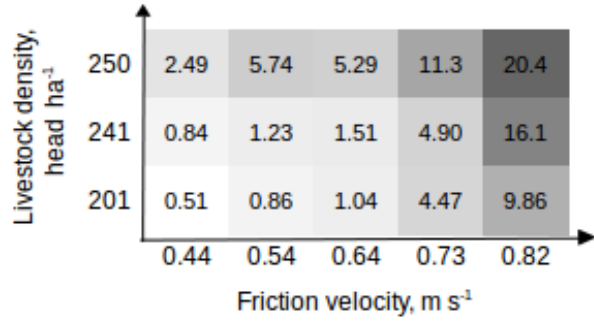
Figure 7. A table chart of the scale factor ( F N /F REF ) with differ- ent u ∗ and N values of 201, 241, and 250headha − 1 yr − 1 . A color gradient from light to dark gray corresponds to an increase in the scale